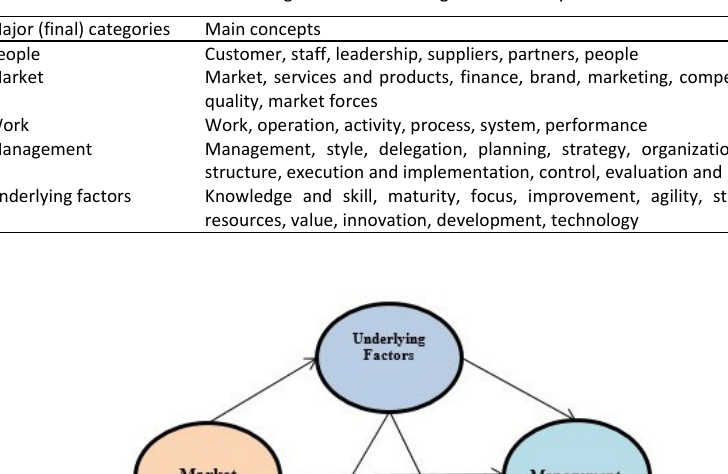
Table 2: Categorization of Finding Content analysis